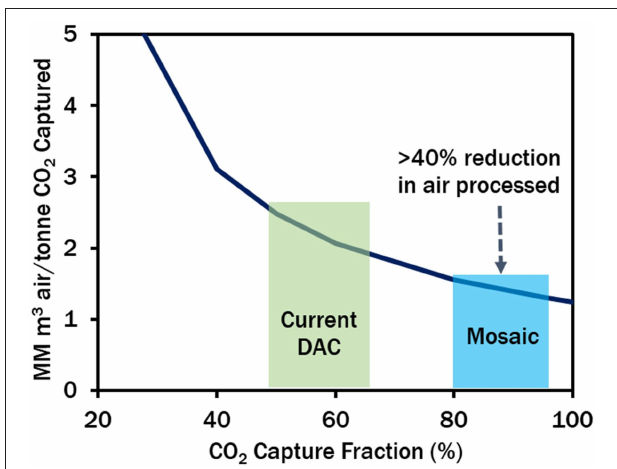
FIGURE 2 | Representation of the air required (in millions of m 3 ) to capture 1 tonne of CO 2 as a function of capture fraction in a DAC process. Current technologies operate under low capture fraction regimes, whereas Mosaic’s efficient sorbent technology can reduce required air handling > 40% depending upon ultimate performance under process